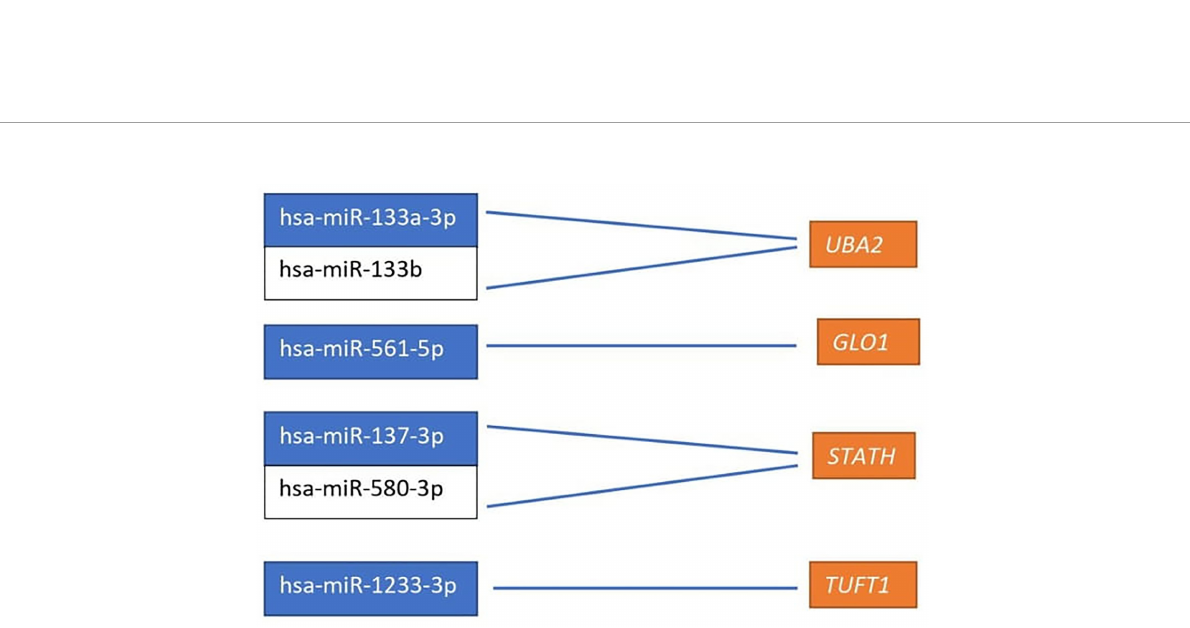
FIGURE 3 miRNAs affecting the transcriptional activity of genes differentiating ovarian cancer samples compared to the control samples. UBA2 , ubiquitin- like modi fi er-activating enzyme 2; GLO1 , glyoxalase I; STATH , statherin, TUFT1 , tuftelin 1; RIC8A , RIC8 guanine nucleotide exchange factor B; ABCC5 , ATP-binding cassette subfamily C member 5; HPD , 4-hydroxyphenylpyruvate dioxygenase; GBF1 , Golgi brefeldin A-resistant guanine nucleotide exchange factor 1.